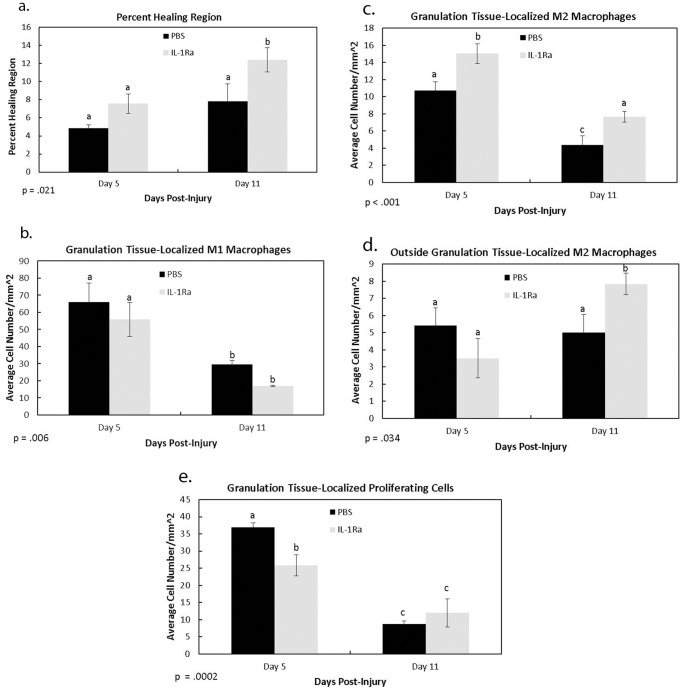
Immunohistochemistry results of selected cellular factors regulated by IL-1Ra.Graph of the percent healing region (a), granulation tissue localized M1 macrophages (b), granulation tissue-localized M2 macrophages (c), M2 macrophages outside the granulation tissue (d), and granulation tissue-localized proliferating cells (d), at 5 and 11 days post-injury after PBS or IL-1Ra treatment. On day 11, IL-1Ra significantly increased the percent healing region (a). No differences within the MCL were observed at any other points. Although no differences were observed with M1 macrophages (b), IL-1Ra treatment increased M2 macrophage numbers at day 5 and/or day 11 within (c) and outside of the granulation tissue (d). Proliferating cells were significantly reduced at day 5 (e). a,b,c indicates within a graph, bars without a common superscript letter differ (results of Fisher’s LSD post-hoc pairwise analysis, p<.05). Values are expressed as mean cell numbers ± S.E.M.